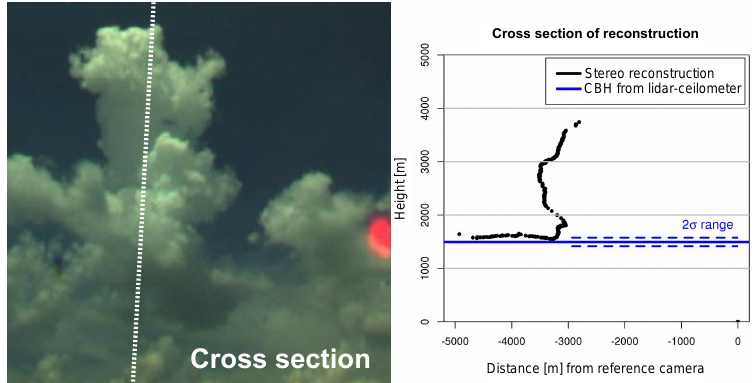
Figure 19. Cross section of the reconstruction from 24 July 2014,